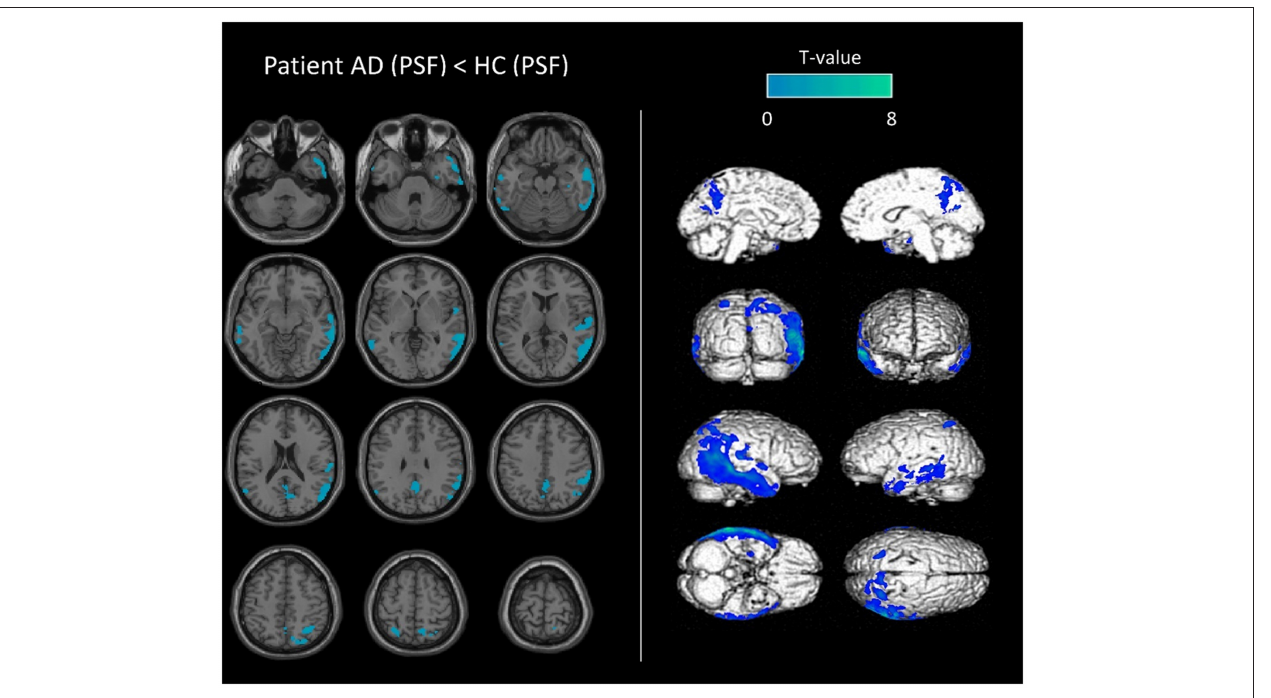
Frontiers in Medicine | www.frontiersin.org